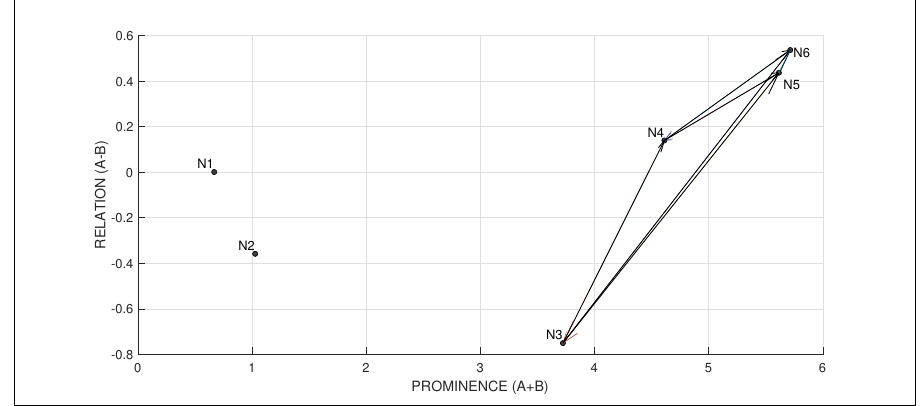
Figure 3. Relational chart.